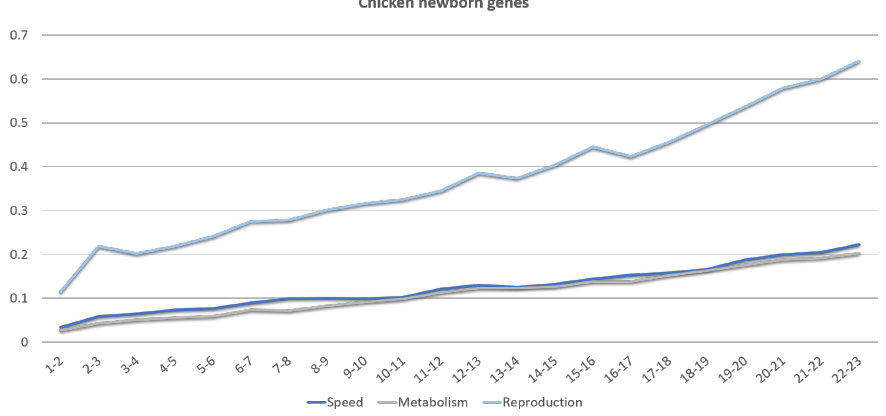
Figure 24. The diagram shows the gene types used in the generations. Because of the natural selection effect, all gene types are constantly upgrading in the rate of their mutation range (reproduction had the biggest range).